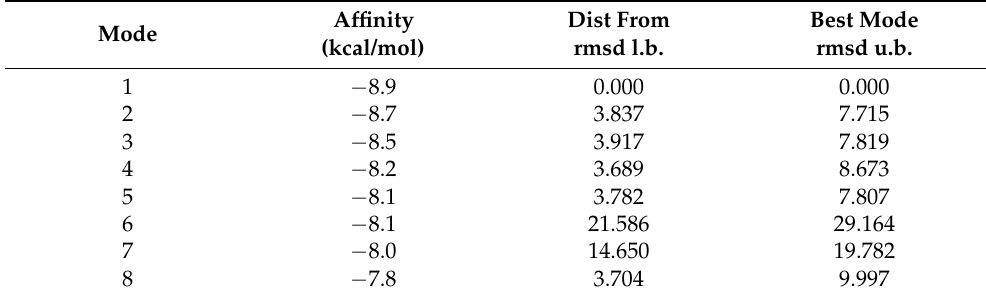
Affinity (kcal/mol)